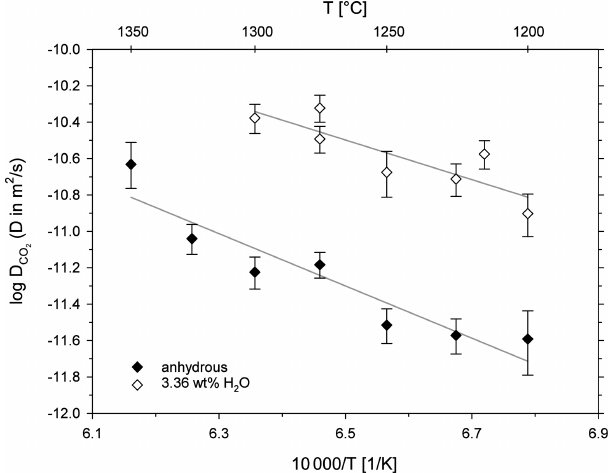
Figure 6. Arrhenius diagram for CO 2 diffusion in leucititic melt; the grey lines represent the linear Arrhenius